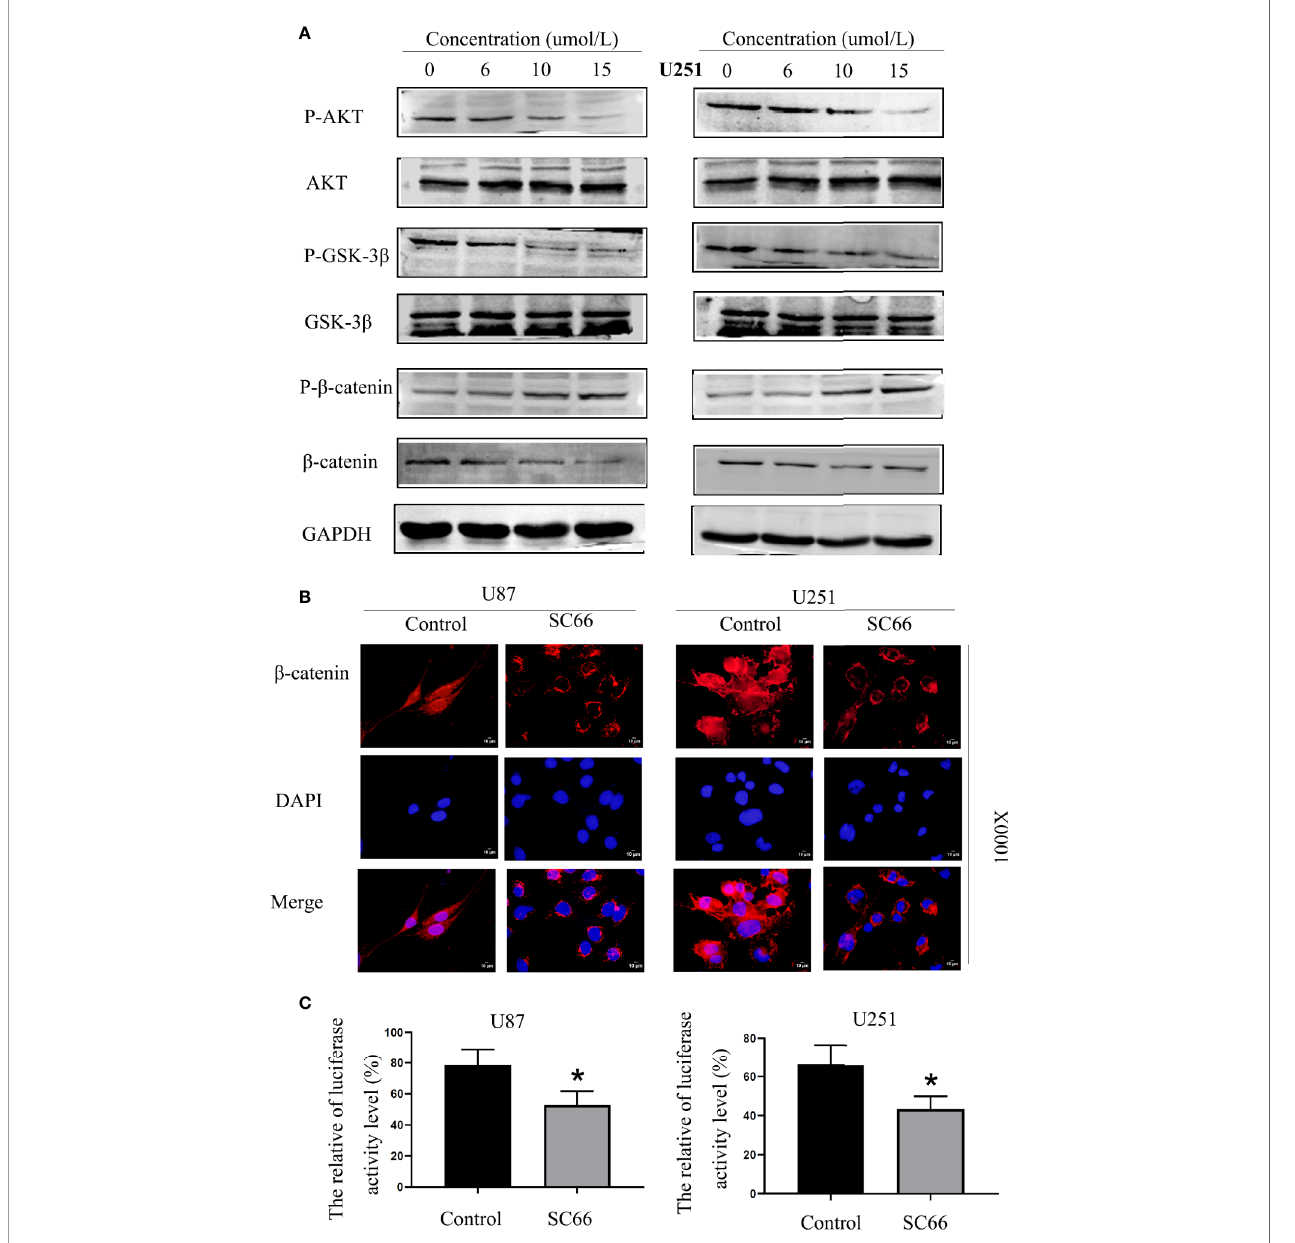
FIGURE 5 | SC66 inhibits AKT/ b -catenin signaling pathways in U87 and U251 cells. (A) Western blot assay of main protein expression of signaling pathways after SC66 treatment. (B) Representative fl uorescent images of b -catenin in U87 and U251 cells. Nuclear transfer level of b -catenin was remarkably decreased after SC66 treatment compared with control group. (C) The relative TCF/LEF luciferase activity is shown as the percentage of relative light units of fi re fl y luciferase to Renilla luciferase. For at least three independent experiments. *P <